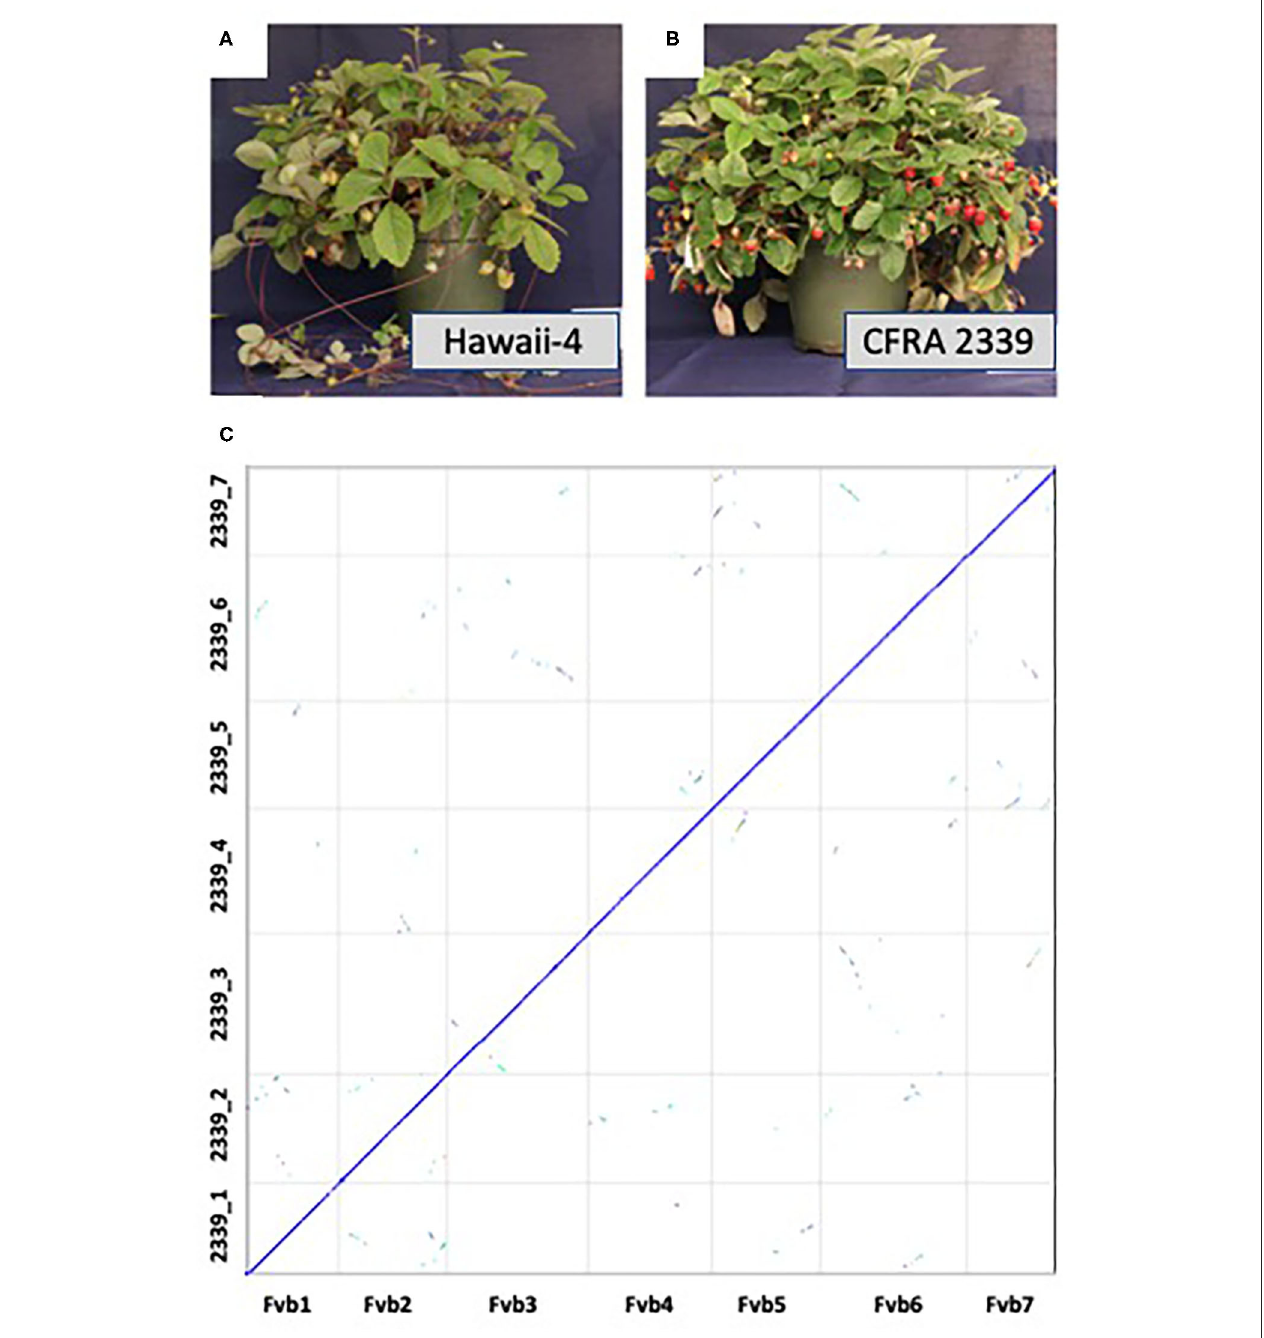
FIGURE 1 | Pictures of mature Fragaria vesca Hawaii-4 (A) and CFRA 2339 (B) . Hawaii-4 produces runners and yellow fruit, while CFRA 2339 is runnerless and produces red fruit. (C) depicts synteny between the final assembly of F. vesca Hawaii-4 (x-axis) and CFRA 2339 (y-axis). Synteny analysis was performed in CoGe [Comparative Genomics, https://genomevolution.org/coge/ (accessed April 10, 2021)] with coloring coding depicting the number of synonymous substitutions. Syntenic orthologous regions between the two accessions are shown on the diagonal in blue, and duplicated genes retained from a whole-genome triplication event [At-gamma (Bowers et al., 2003)] are off-diagonal in other colors. This analysis and figure can be regenerated here: https://genomevolution.org/r/1hdms.